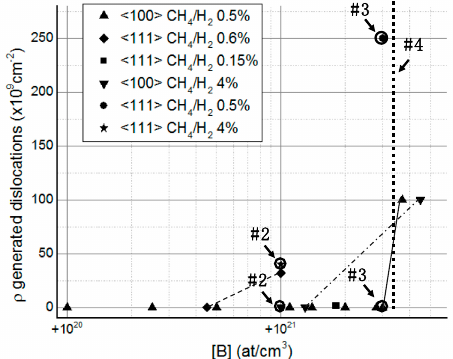
Figure 4. Density of dislocations as a function of the boron doping level of p + layers obtained in [15], where circles correspond to samples grown along the <100> direction and stars correspond to samples grown along the <111> direction. Points highlighted by black circles correspond to the samples studied in regions grown along the <100> and <111> directions, respectively. Results from sample 4 are represented as a vertical dashed line, because it was not possible to determine the density of dislocations generated on each single